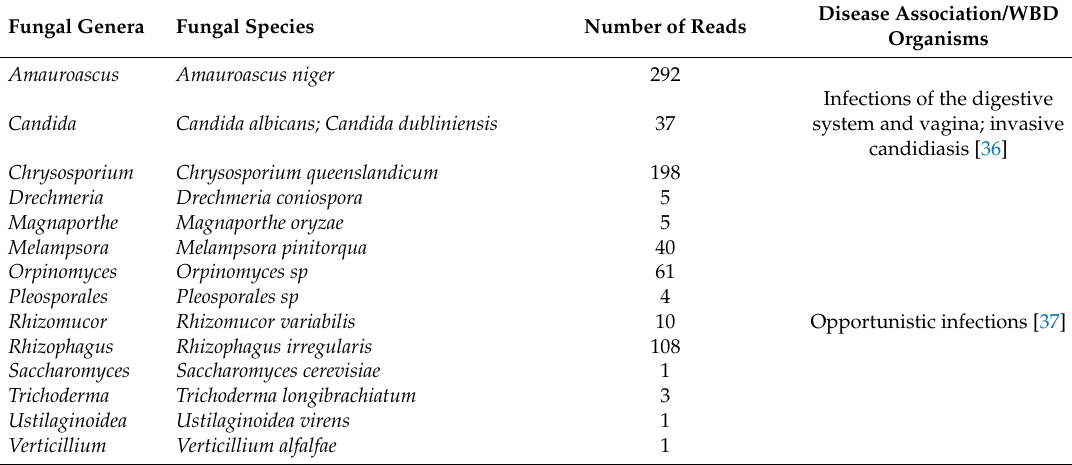
Table 2. List of fungal genera and species, some of which are known pathogens, identified as present in the Little Bighorn River metagenome (DNA prepared without